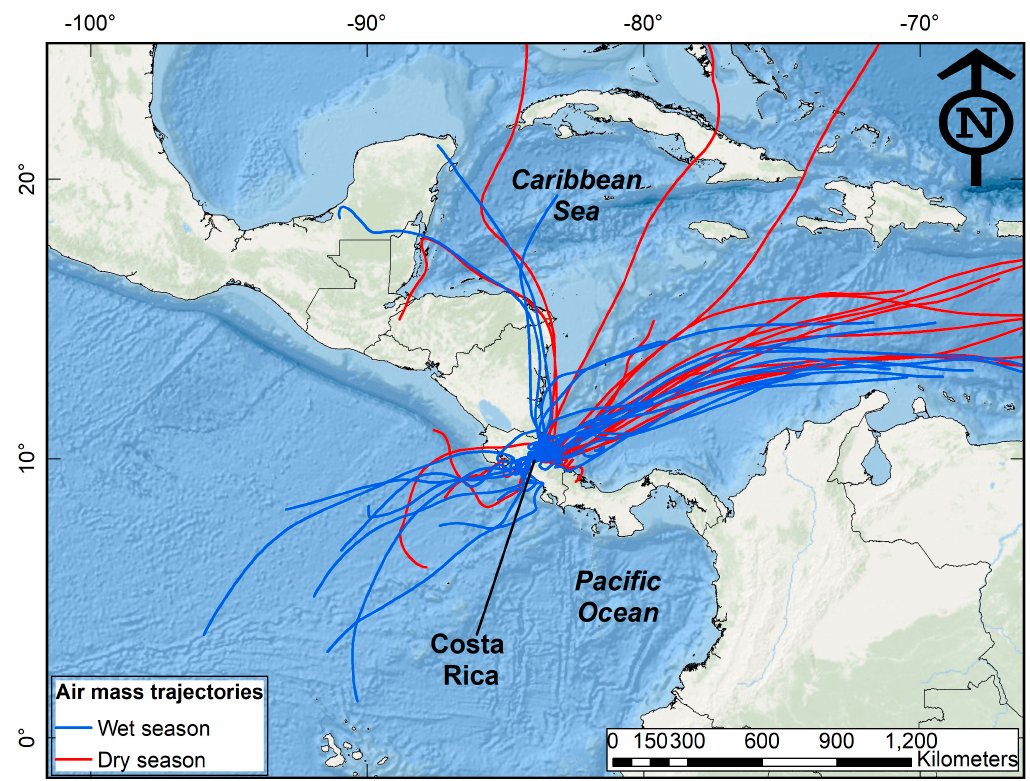
Figure 3. Representative 72-h air mass back trajectories for the dry (red) and wet (blue) seasons in 2017 calculated using the HYSPLIT Lagrangian model [26].